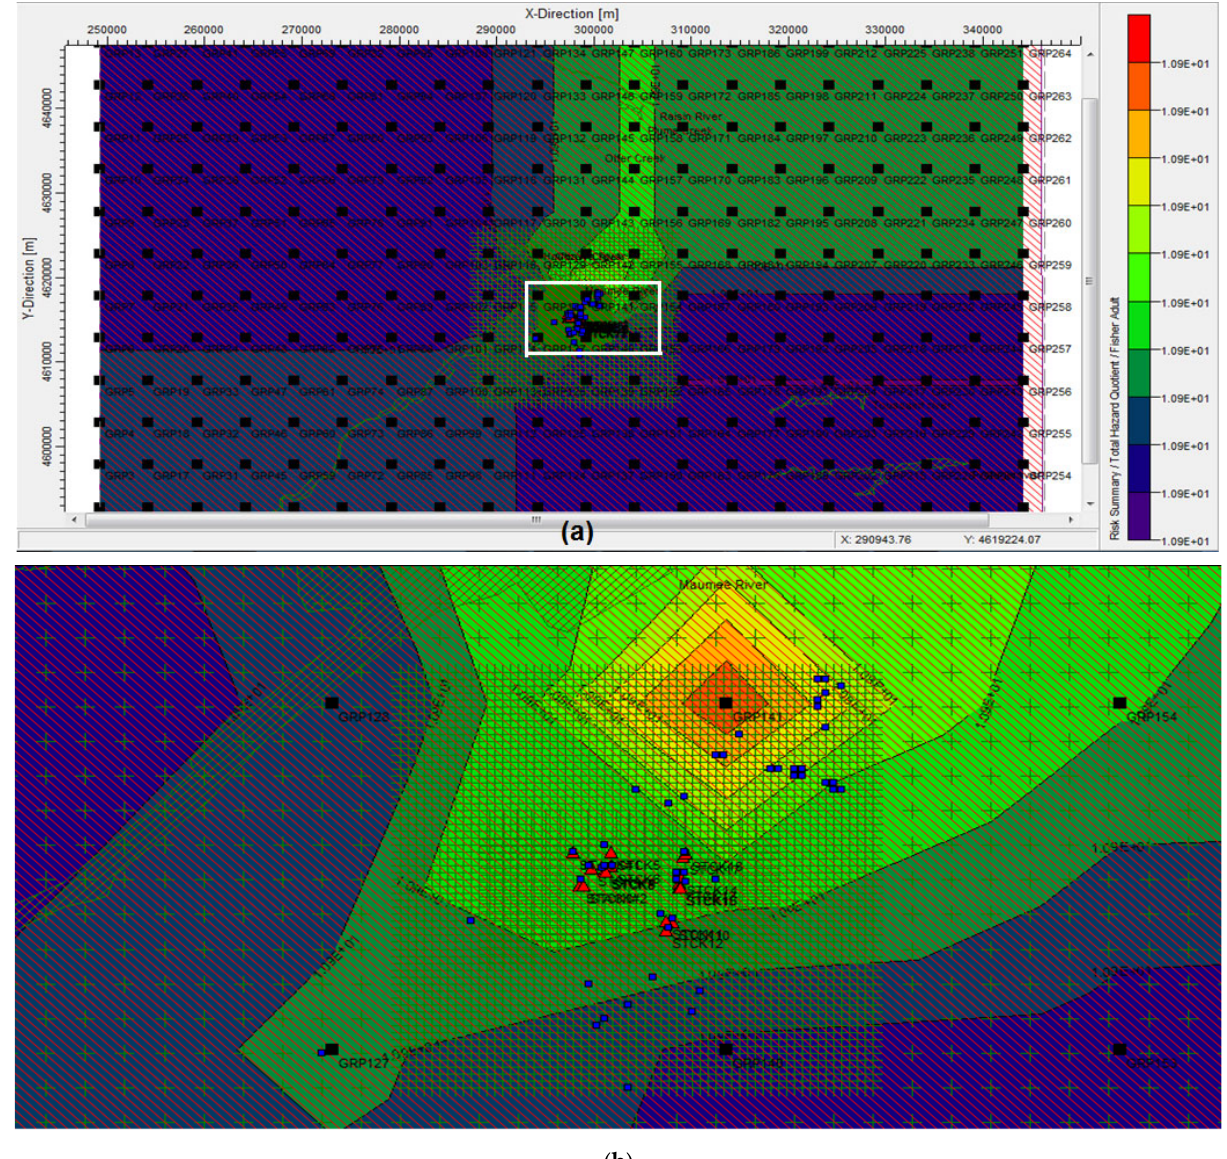
Figure 7. ( a ) Contour plot of the total hazard quotient for location 4. ( b ) Magnification of the area enclosed by white rectangle in ( a ).